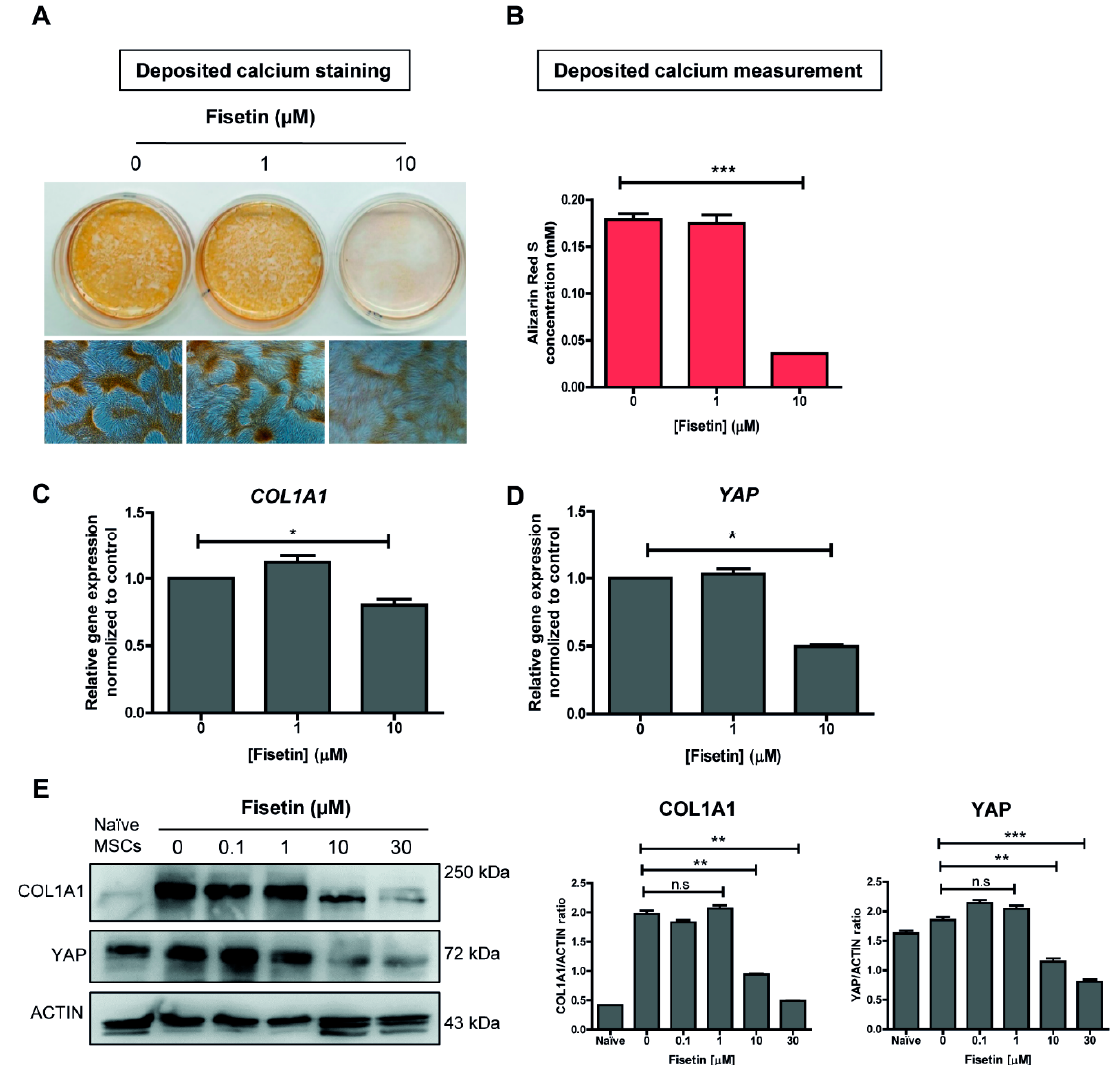
Figure 2. Osteogenic differentiation of MSCs upon fisetin treatment. Fisetin treatment at 10 µ M inhibits osteogenic differentiation (as determined by Alizarin Red S staining) and quantitative measurement ( A , B ). Transcriptional analysis of COL1A1 and YAP ( C , D ) and protein expression, and the ratio of COL1A1 and YAP to ACTIN ( E ) upon fisetin treatment as determined by quantitative RT-PCR and western blotting, respectively. The data presented in subfigure ( B – E ) were analyzed by Mann–Whitney U test. Bars indicate mean values ± standard deviation (SD) and asterisks indicate significant differences, * p < 0.05; ** p < 0.01; *** p < 0.001, n.s. = no significant difference .